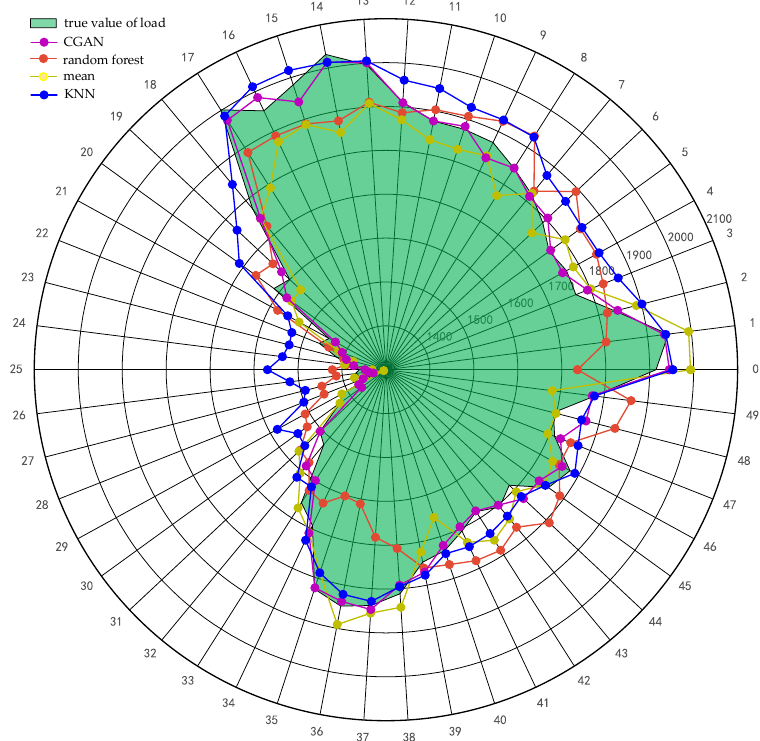
Figure 10. Reconstruction results with a deletion rate of 40%.